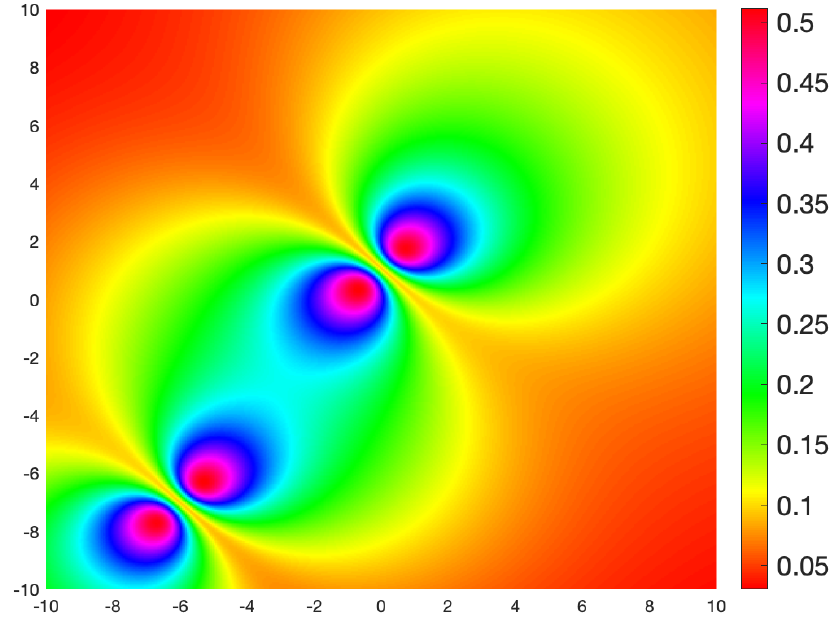
Figure 5. Geodesic speed for each point in Ω = [ − 10,10 ] × [ − 10,10 ] for targets departing each point in direction of the vector (1, −